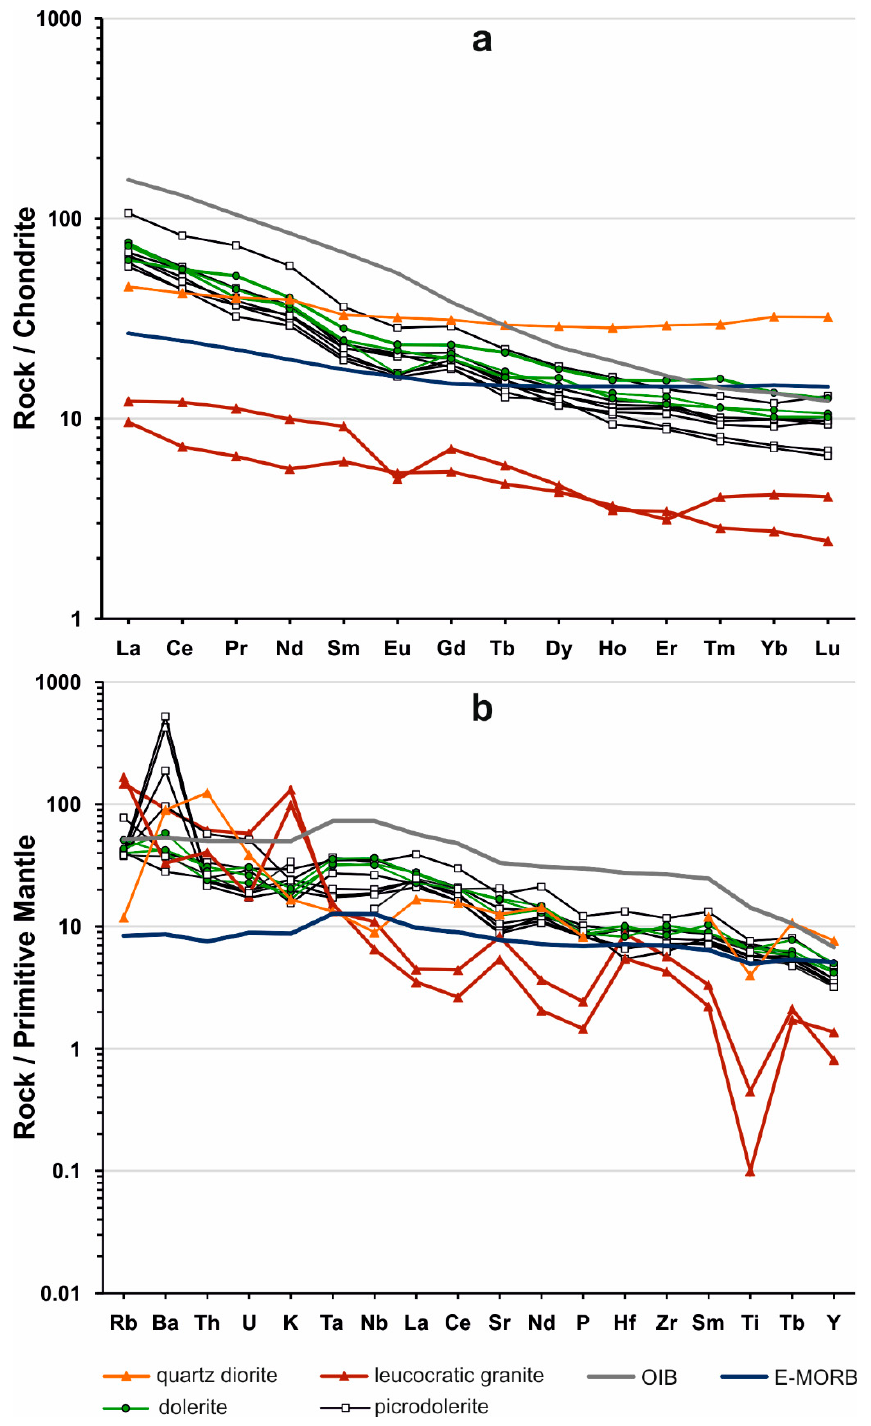
Figure 8. REE ( a ) and spider ( b ) diagrams for the mafic-intermediate-felsic rocks. Elements contents are normalized for chondrite [29] and primitive mantle [30]. are normalized for chondrite [29] and primitive mantle